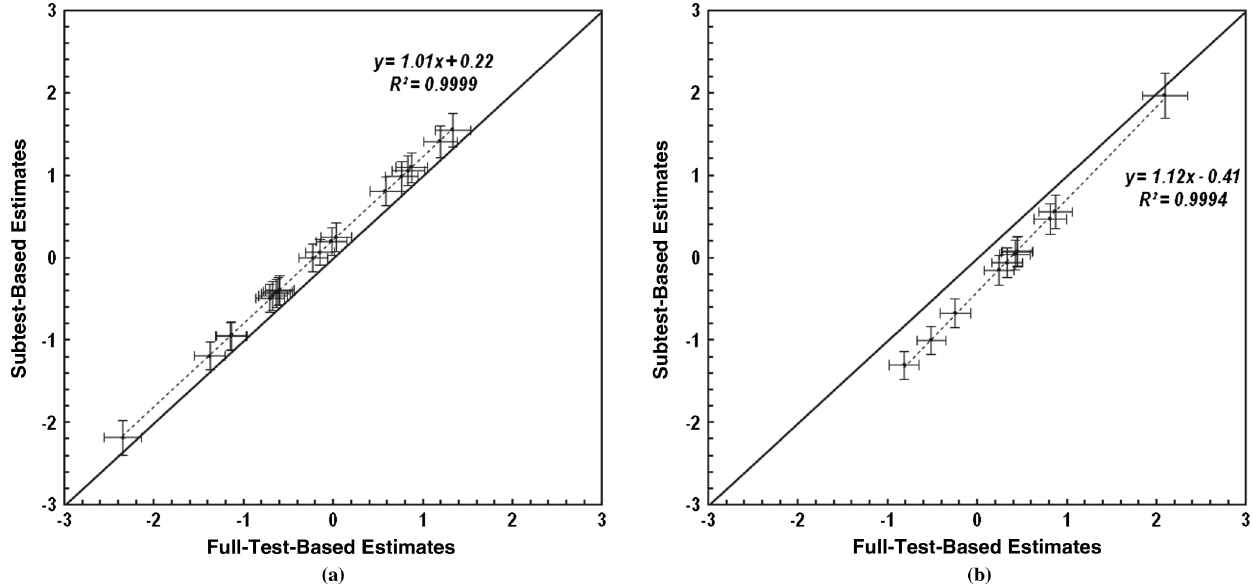
FIG. 3. Scatter plots for full-test-based versus subtest-based BEMA item estimates. (a) Scatter plot for electricity items (item 1 – item 19). (b) Scatter plot for magnetism items (item 20 – item 30).